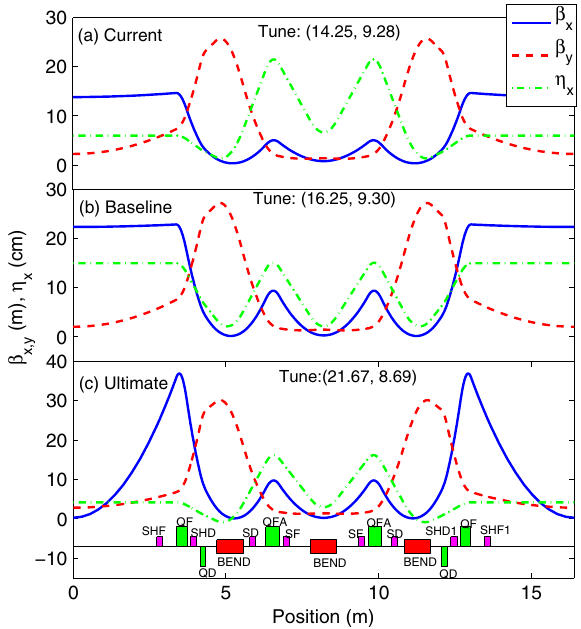
FIG. 1. Layout of one sector of ALS lattice and its associated optics functions for (a) current lattice, (b) baseline upgrade, (c)